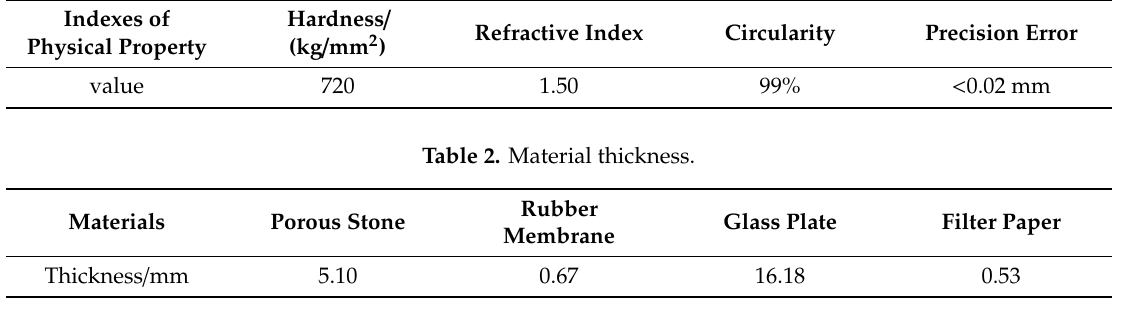
Figure 2. Test materials: ( a ) glass plate, ( b ) porous stone and ( c ) glass plate with rubber membrane. Table 1. Physical properties of glass beads.